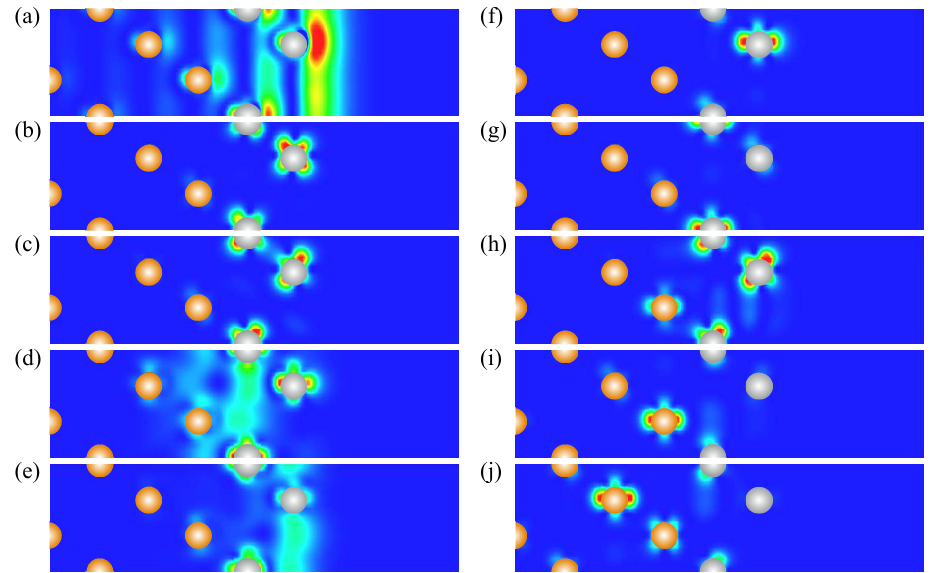
Figure 9. Charge density distribution of (a) Γ 1 , (b) Γ 2 , (c) Γ 4 , (d) M 6 , (e) M 7 , (f) K 8 , (g) K 9 , (h) K 10 , (i) K 11 , (j) K 12 surface, quantum-well, and interface states in the 2 ML-Pt/Au(111) heterostructure. The Pt and Au atomic positions are shown by grey and yellow dots,